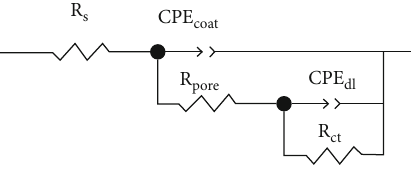
Figure 10: The incorporated electrical equivalent circuit